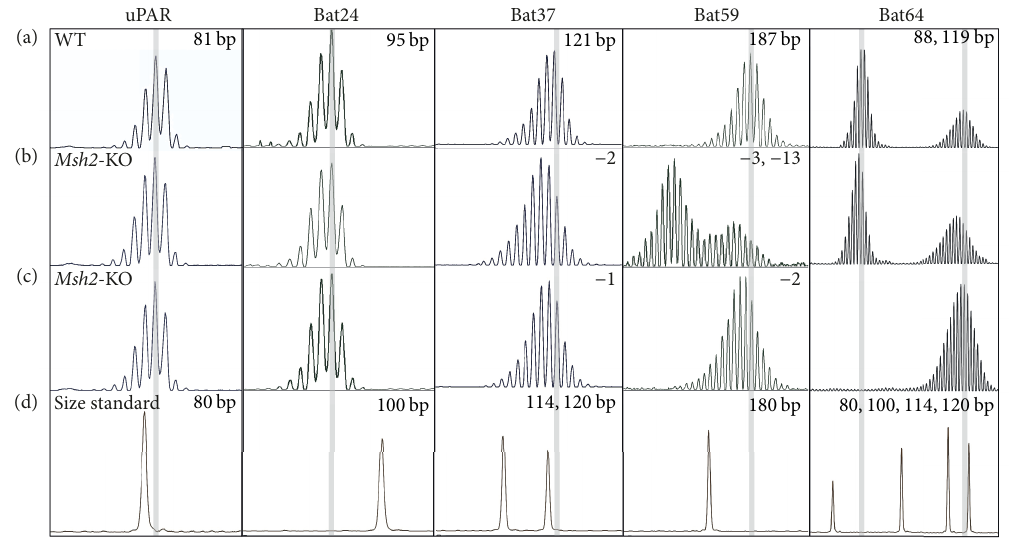
Figure 1: MSI in the normal colon of the Msh2 -KO mouse. (a) Reference pattern of mononucleotide repeat markers uPAR , Bat24 , Bat37 , Bat59 , and Bat64 in a WT mouse. Bat64 shows two alleles. The position of the highest peak in the WT mouse is highlighted with the grey bar and the size is indicated in the top right corner; (b, c) contraction of the repeats in two representative Msh2 -KO mice compared to WT. (d) The position and size of the peaks for the size standard